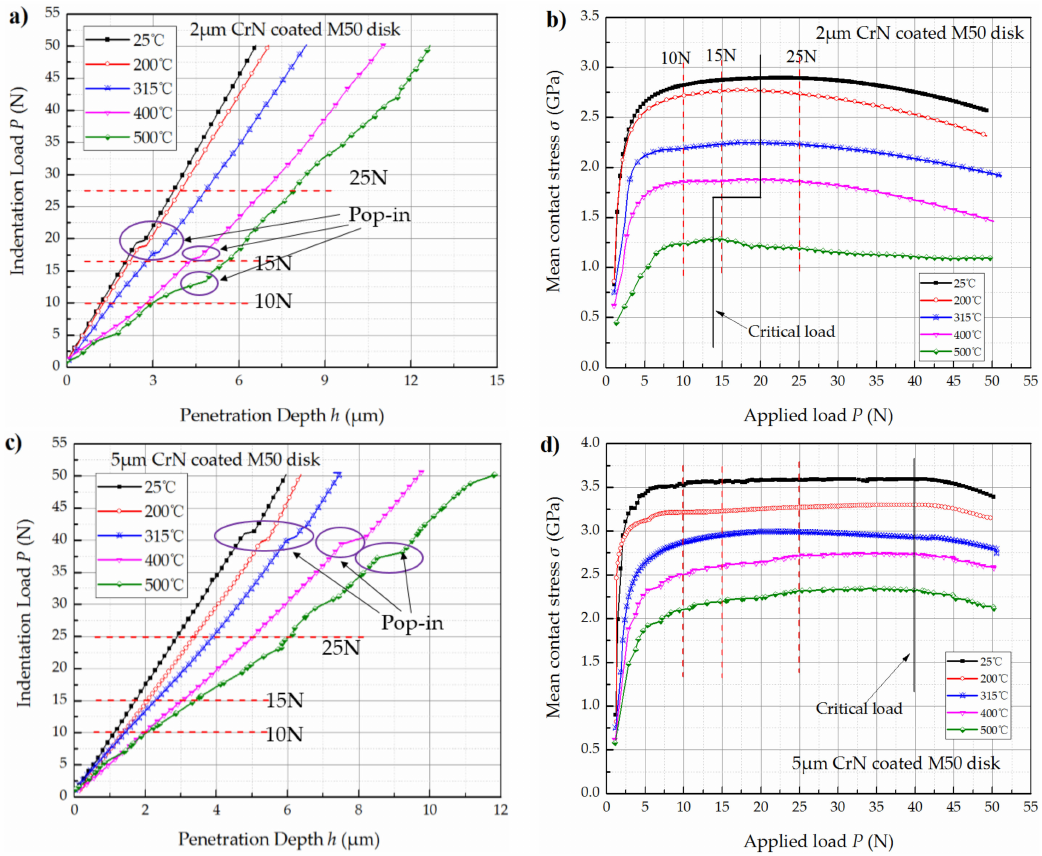
Figure 5. Loading curves and corresponding contact stress curves of the samples as a function of temperatures in the load range of 1–50 N: ( a ) loading curves of 2 µ m CrN coated M50 disk; ( b ) contact stress curves of 2 µ m CrN coated M50 disk; ( c ) loading curves of 5 µ m CrN coated M50 disk; and ( d ) contact stress curves of 5 µ m CrN coated M50